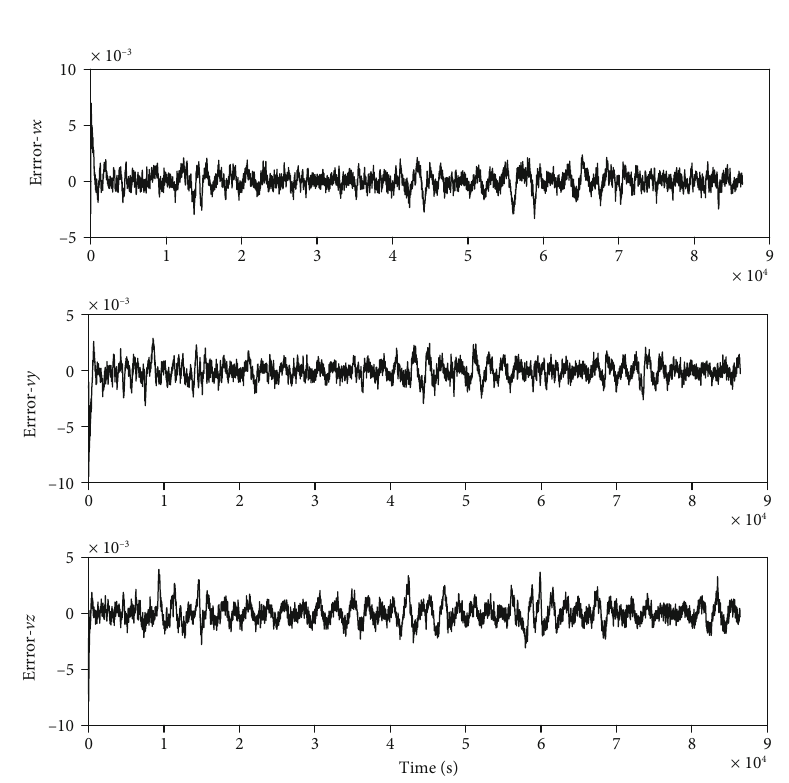
Figure 10: Velocity estimation error (neural